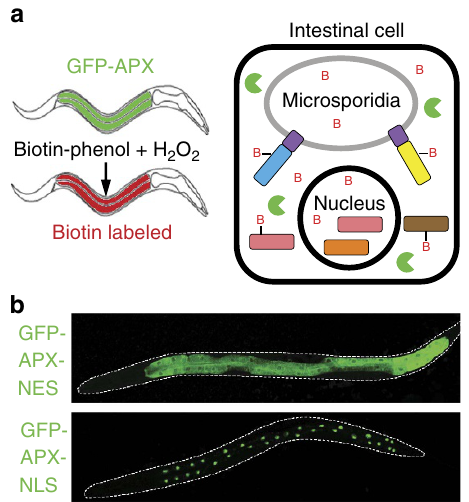
Figure 1 | Overview of approach to detect and analyse host-exposed microsporidia proteins. ( a ) Schematic of spatially restricted enzymatic tagging in C. elegans . Left, worms expressing GFP-APX in the cytoplasm of the intestine and infected with microsporidia are treated with biotin-phenol and H 2 O 2 . This treatment results in proteins within the intestinal cytoplasm being labelled with biotin. Right, an intestinal cell infected with microsporidia expressing cytoplasmic APX (green circular sectors) labelling microsporidia host-exposed proteins with biotin (red B). ( b ) Animals expressing GFP-APX in the intestine localized to either the cytoplasm (top) or the nucleus